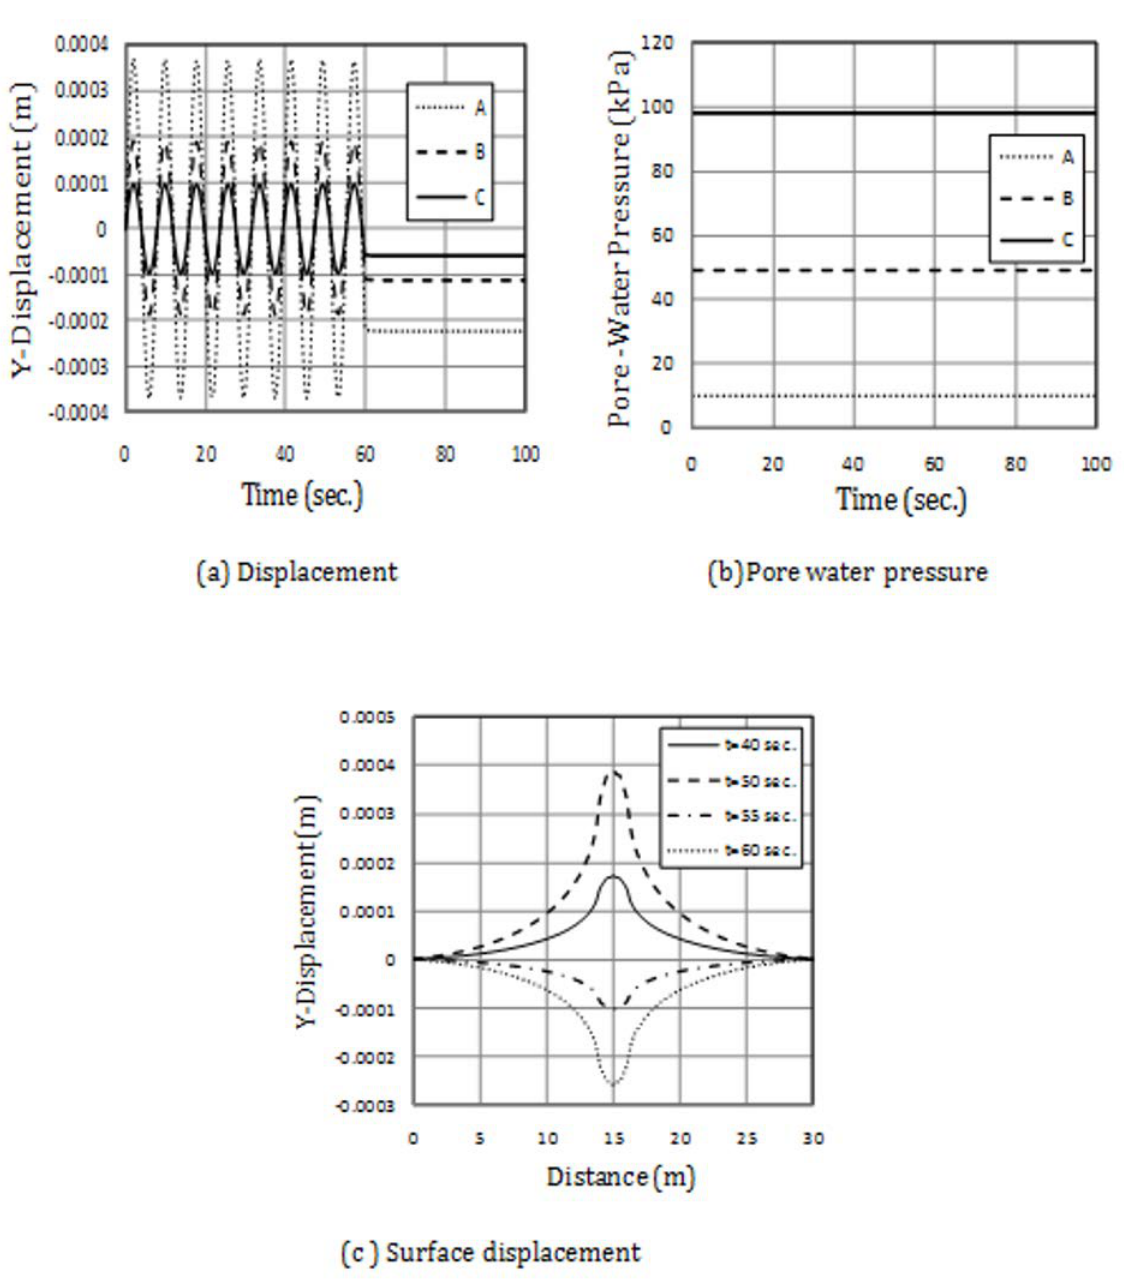
Figure 9. Dynamic response of the foundation to harmonic load, a